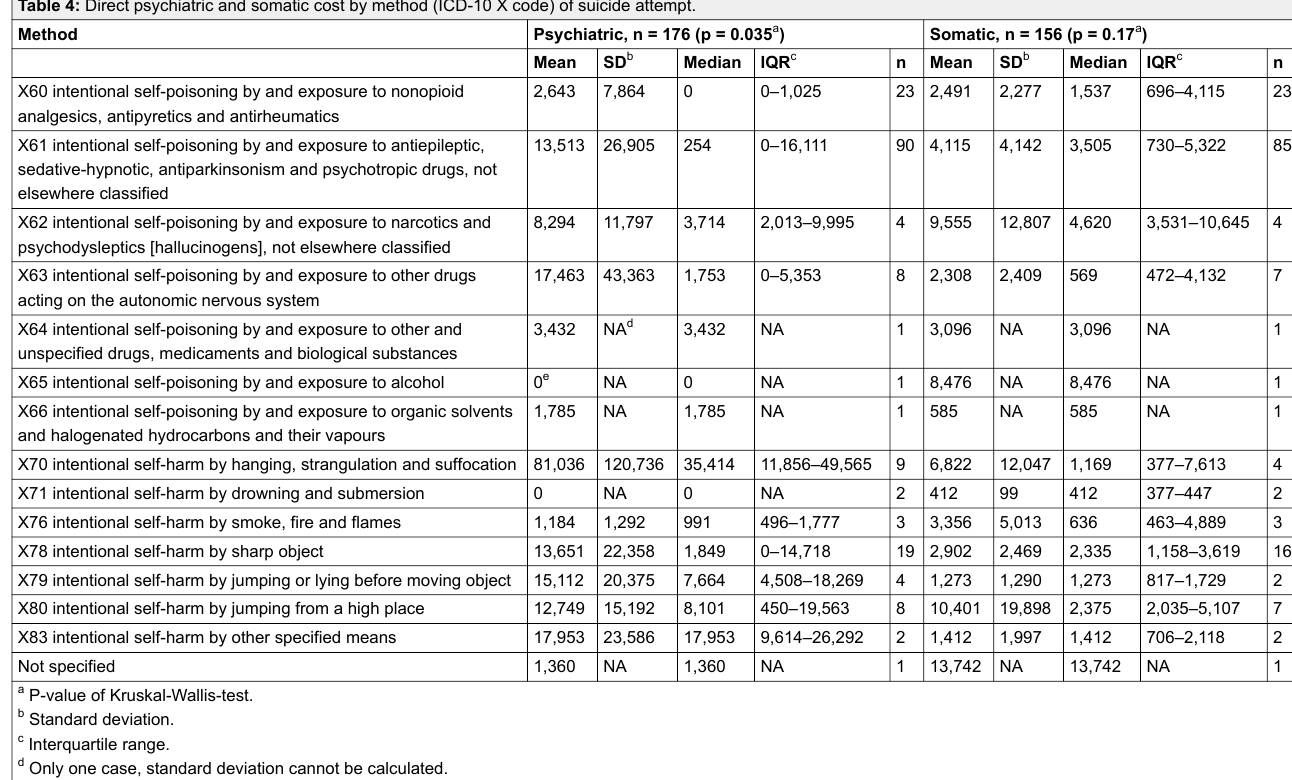
Table 4: Direct psychiatric and somatic cost by method (ICD-10 X code) of suicide attempt.